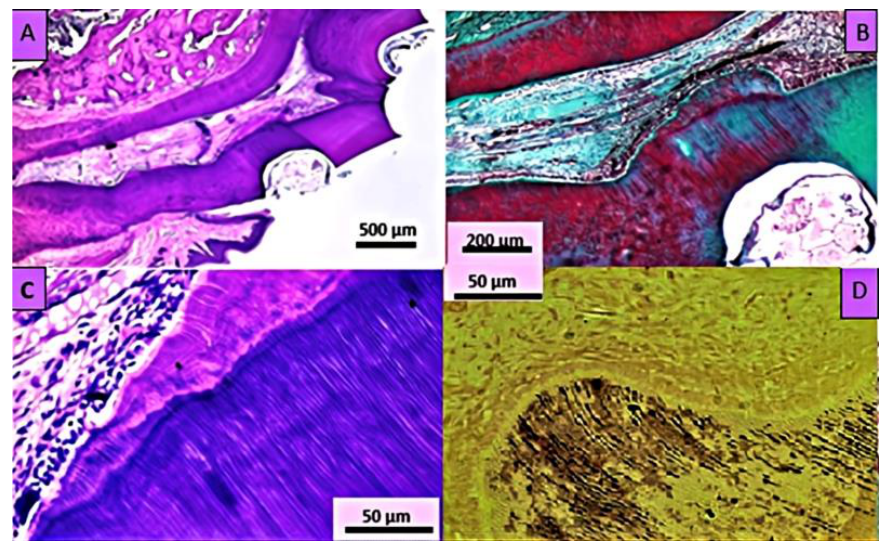
Figure 5. ( A – D ) (4×, 10×, and 40×): Microscopic view of cervical restoration with c-GIC at a 1-month interval (H&E and trichrome showing new dentin formation). ( D ) shows the bacterial detection under Brown and Brenn staining.